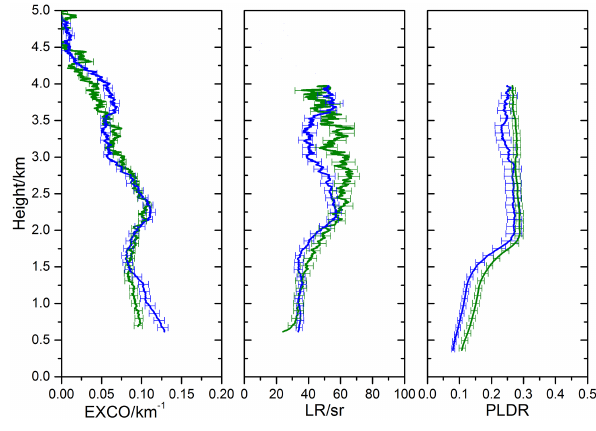
Figure 11. Same as Fig. 5 but for 11 July 2013, 23:00–24:00UTC.